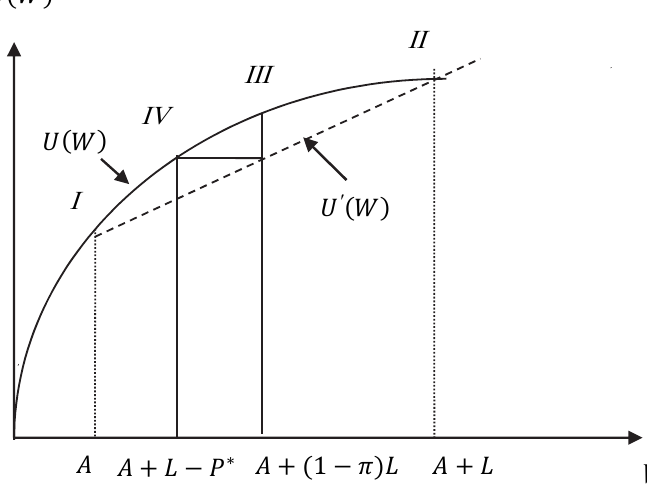
Fig. 1. Utility function in 'Insurance' and 'No Insurance'